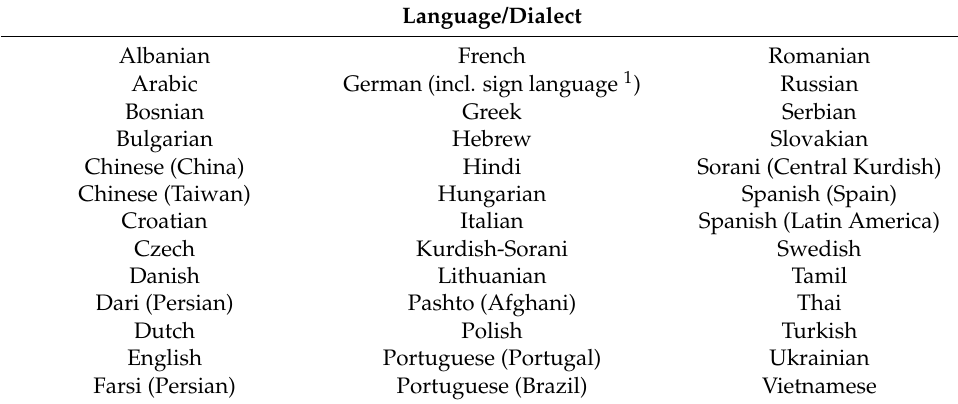
Table 1. Languages and dialects ( n = 39) supported by the app (in alphabetical order).